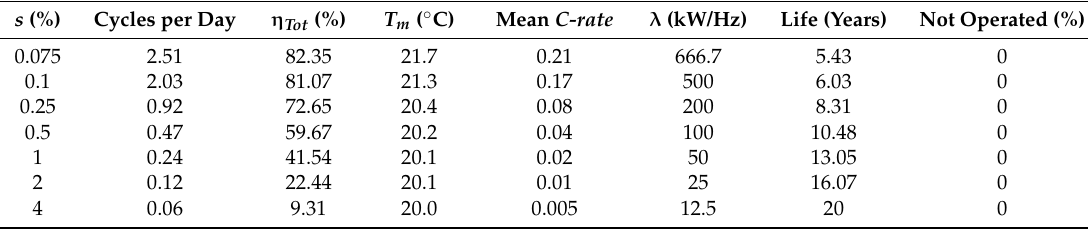
Table 4. PFC results: C-rate = C/2, T 0 = 20 ◦